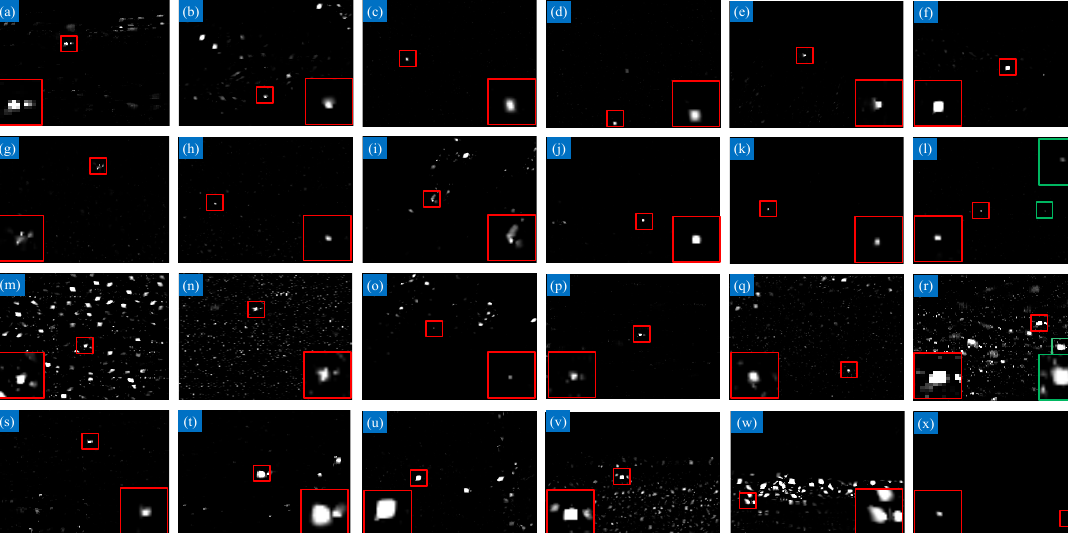
Figure A5. The separated target images of IPI under 24 scenes.